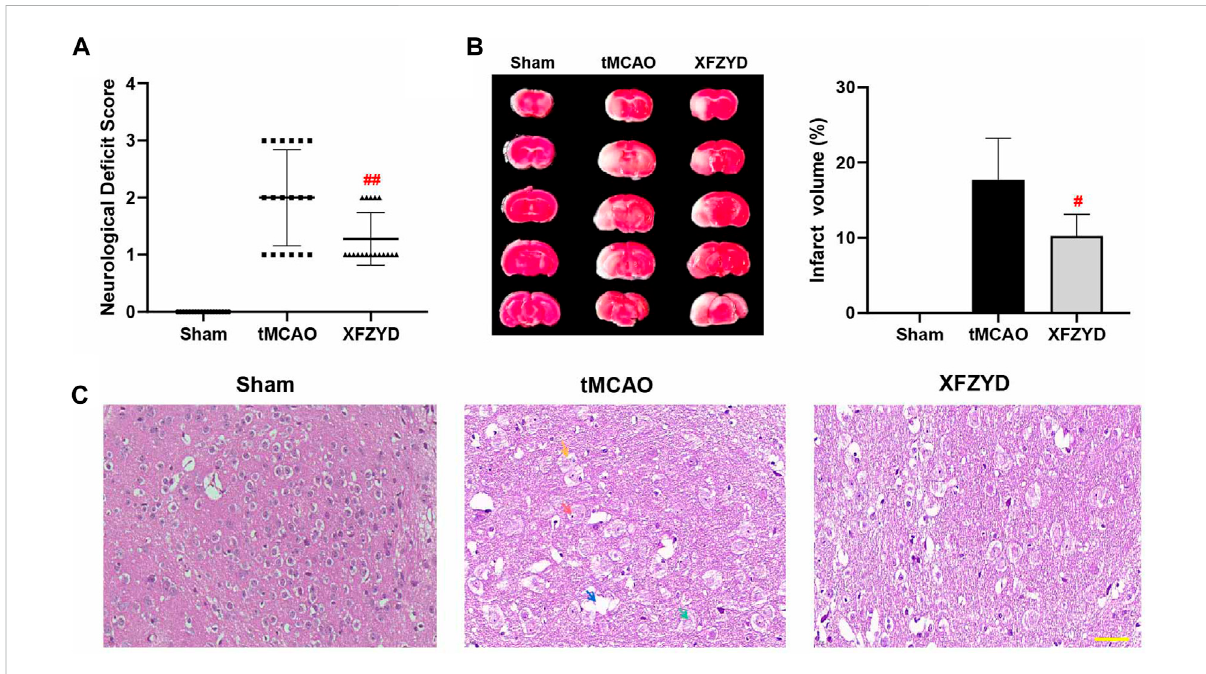
FIGURE 2 XFZYD pretreatment promoted neurological protection after tMCAO surgery. (A – B) Neurological de fi cit scores and TTC staining were measured 24 h after surgery. (A) Comparison of neurological de fi cit scores in tMCAO and XFZYD groups (n = 18 in each group, ## p < 0.01 vs. the tMCAO group). (B) Representative brain sections stained with TTC are shown and infarct volume was quanti fi ed and compared between the XFZYD and tMCAO groups (n = 6 in each group, # p < 0.05 vs. the tMCAO group). (C) Representative photomicrographs of HE staining (Scale bar, 50 μ m). Nerve cells in the infarcted area had incurred damaged, as demonstrated by nucleolus pyknosis (red arrow), fragmentation (yellow arrow), nucleolus dissolution (green arrow) and vacuolated spaces (blue arrow).